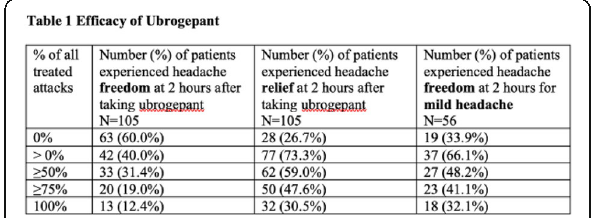
Table 1 (abstract P0259). See text for description